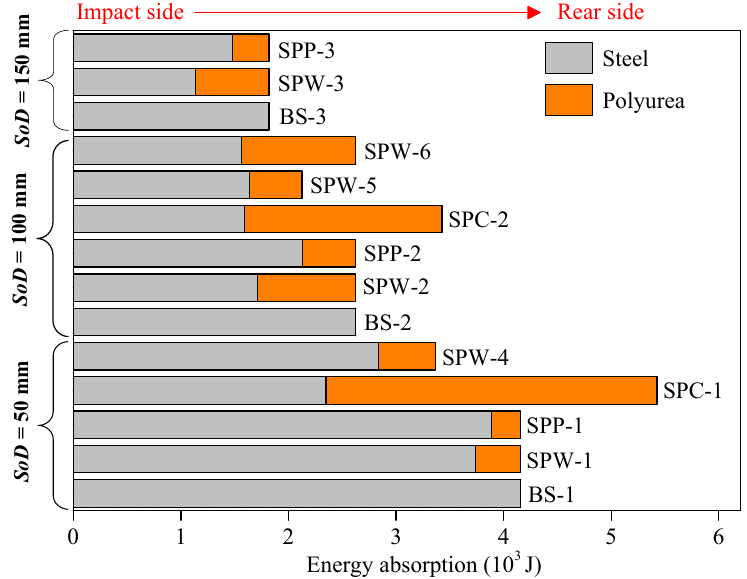
Figure 12. Influence of spraying strategy on the energy absorption of polyurea ‐ coated steel plates.